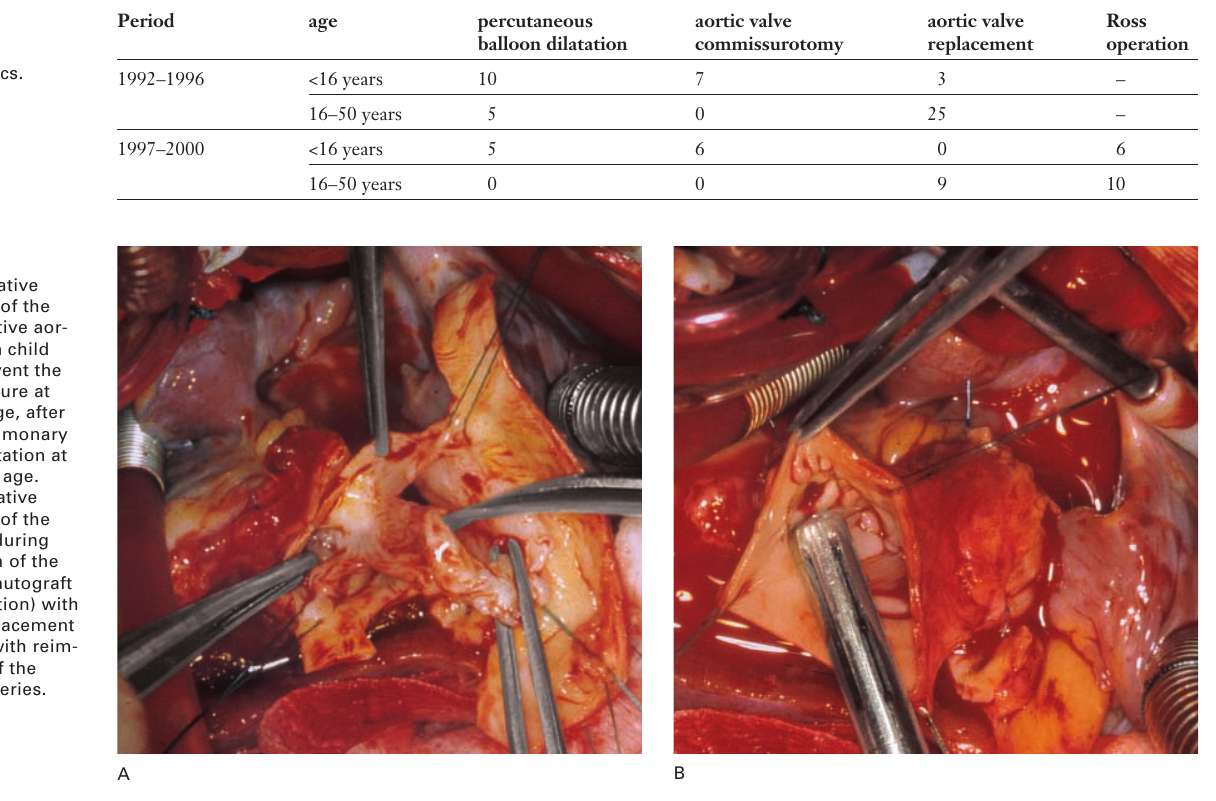
Patient characteristics.